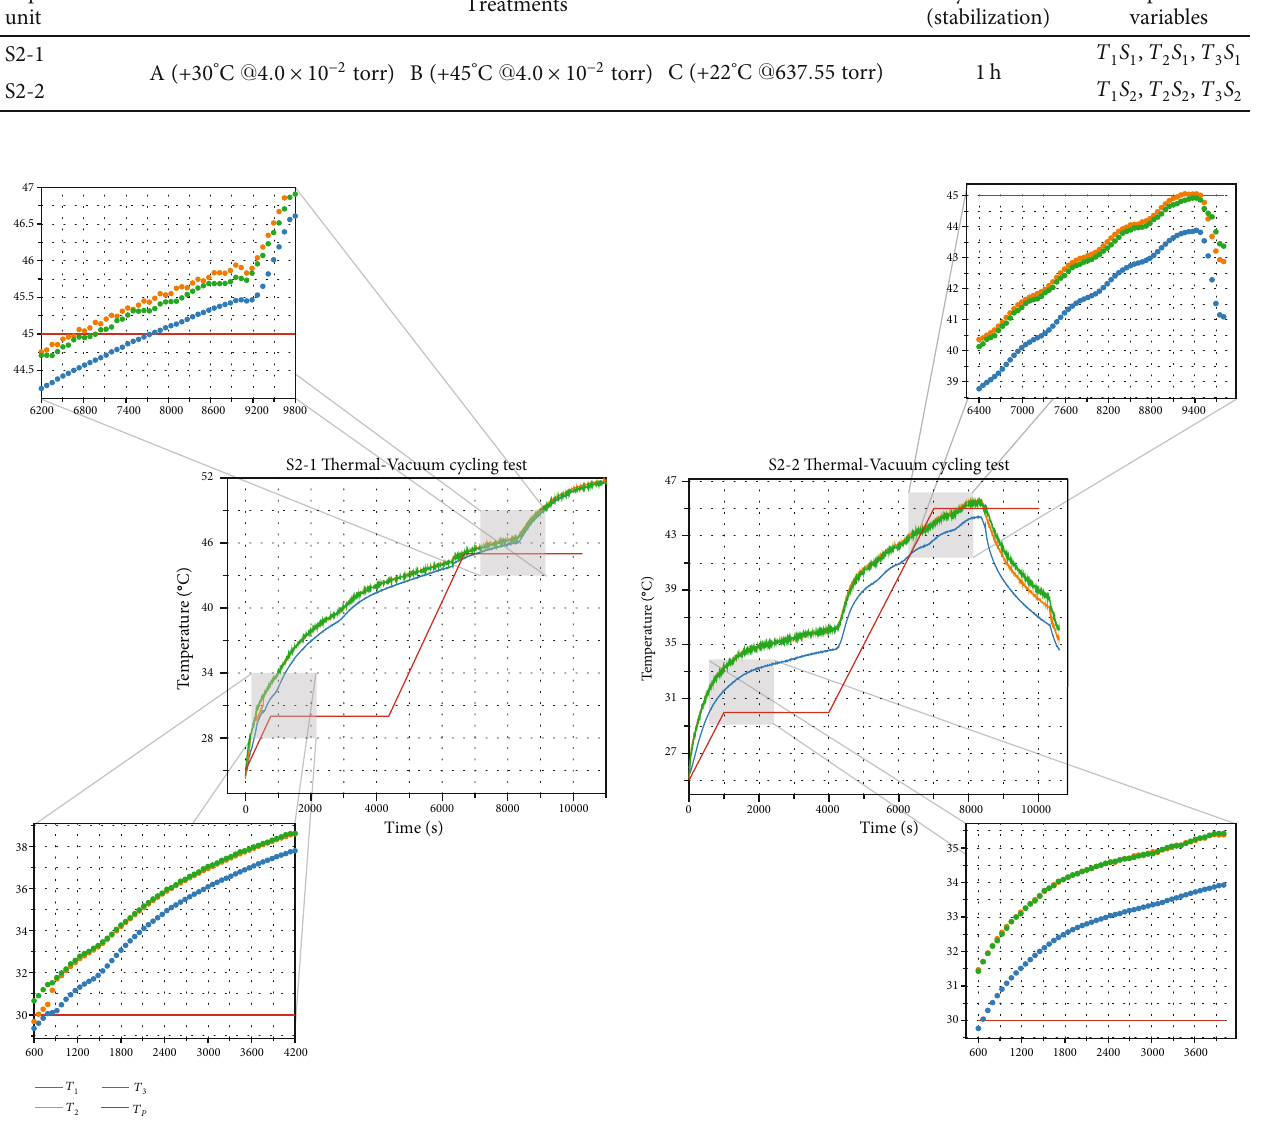
, T , and T , speci fi ed in Table 1 2 3